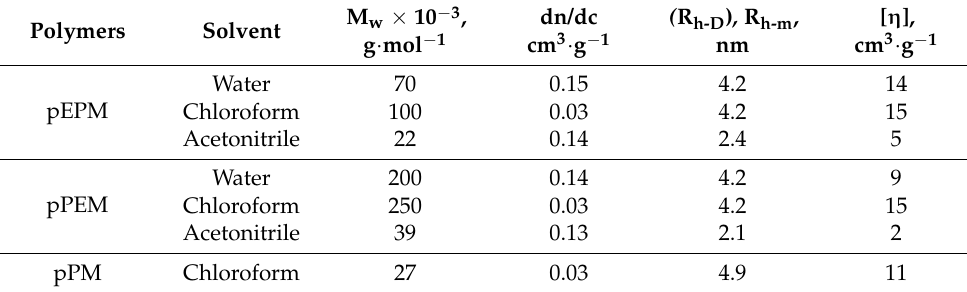
Table 2. Molar mass and hydrodynamic characteristics of polymers.